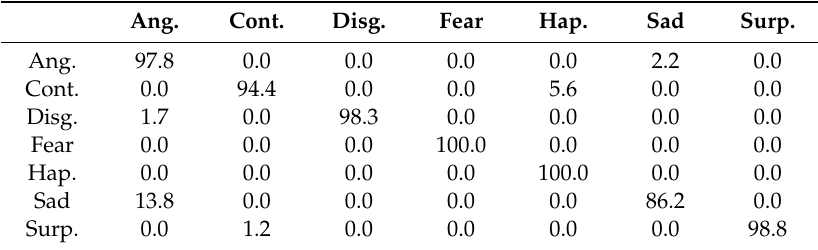
Table 6. The confusion matrix of VSHNN with FS module for CK + dataset. Ang. Cont. Disg. Fear Hap. Sad